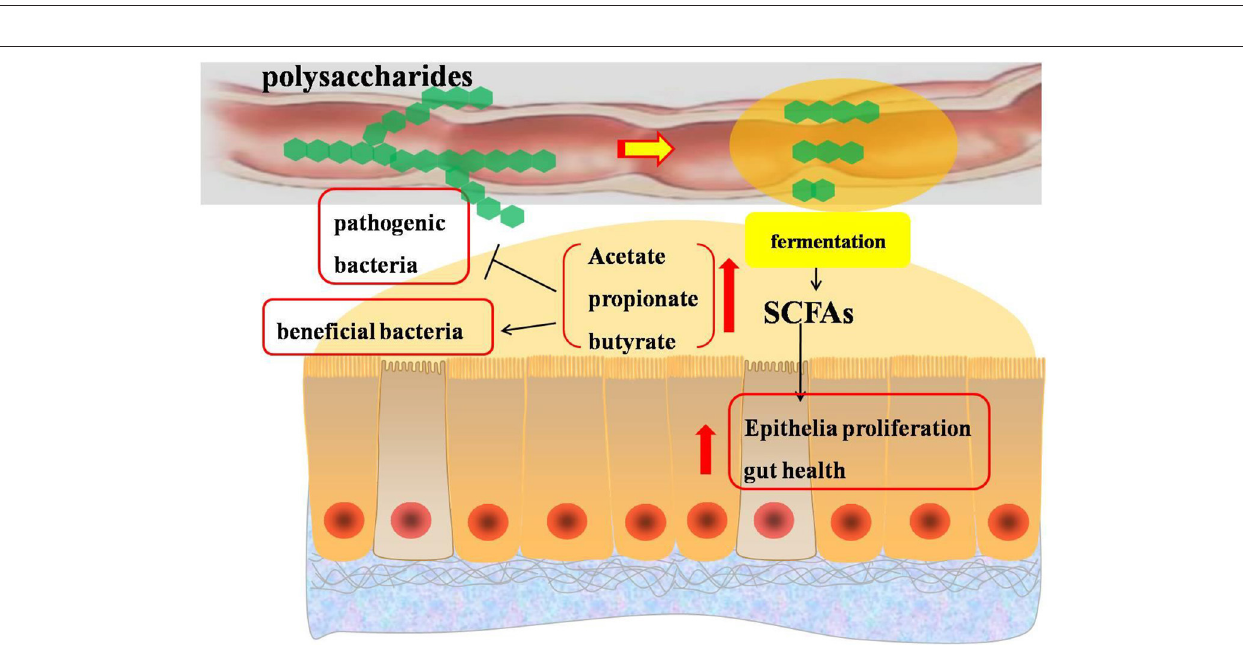
FIGURE 4 | Effects of polysaccharides on short-chain fatty acids in the intestine of broilers. SCFAs, short-chain fatty